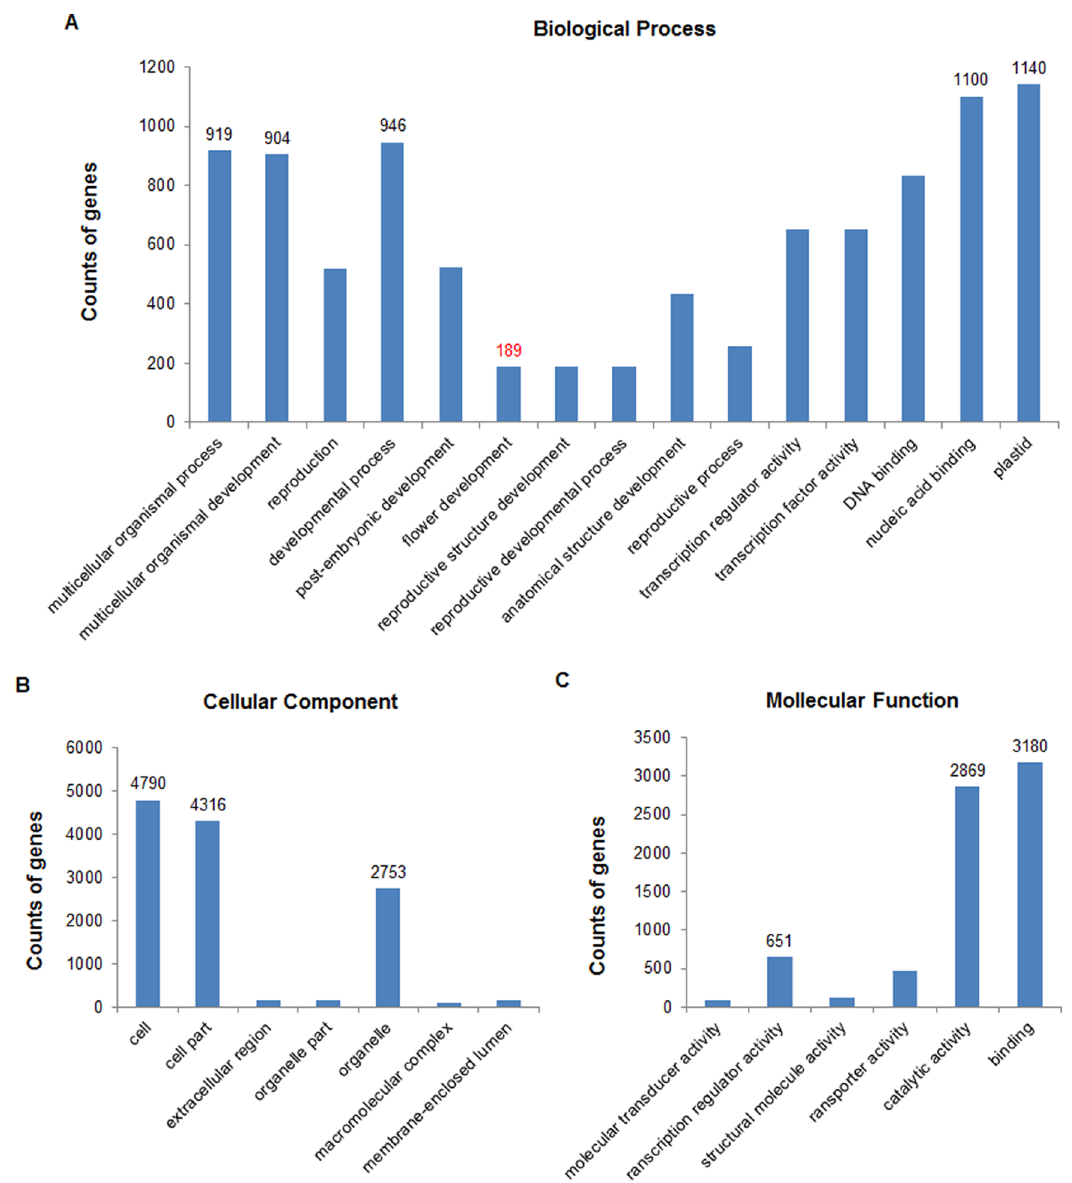
Figure 5. Gene ontology (GO) categories of target genes of known and new miRNA families. Categorization of miRNA target genes was performed according to the three GO domains; Biological Process (A), Cellular Component (B), and Molecular Function (C). expressed flowering miRNAs are F-miRNAs, except for oru-miR4, which is an E-miRNA. This further indicates that both F-miRNAs and E-miRNAs display spatio-temporal-specific expression pat- terns, but that N-miRNAs are highly conserved and have functional roles similar to housekeeping genes.